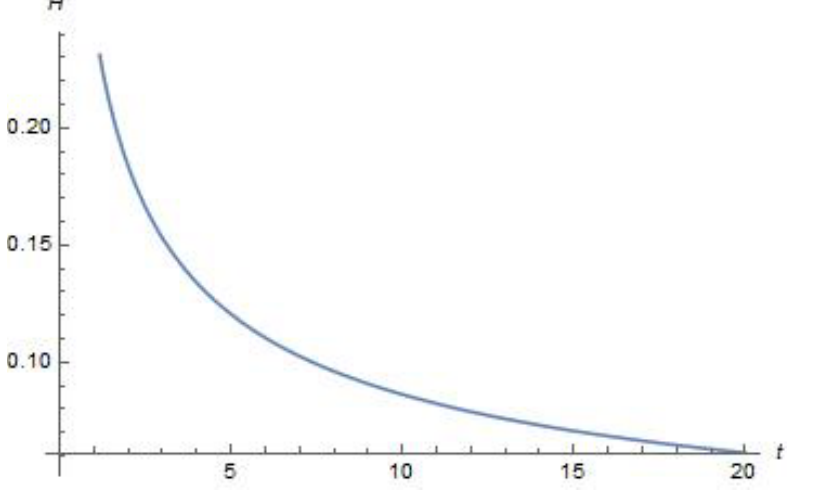
Figure 1. Hubble parameter H (in Gyr − 1 ) against time t (in Gyr ).